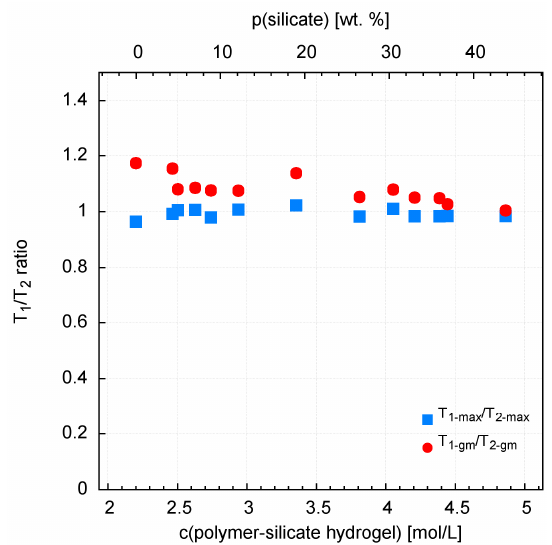
/ T Figure 8. T 1 /T 2 ratio for the polymer-silicate hydrogel samples. Figure 8. T 1 2 ratio for the polymer-silicate hydrogel samples.